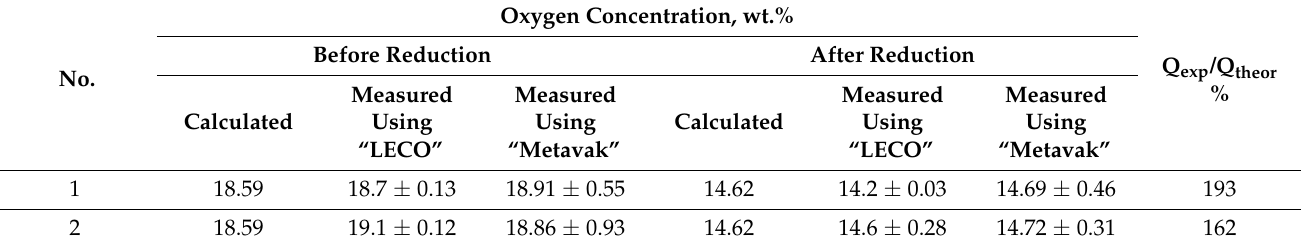
Table 9. Calculated and experimental values of the oxygen concentration in CeO 2 pellets before and after the reduction.